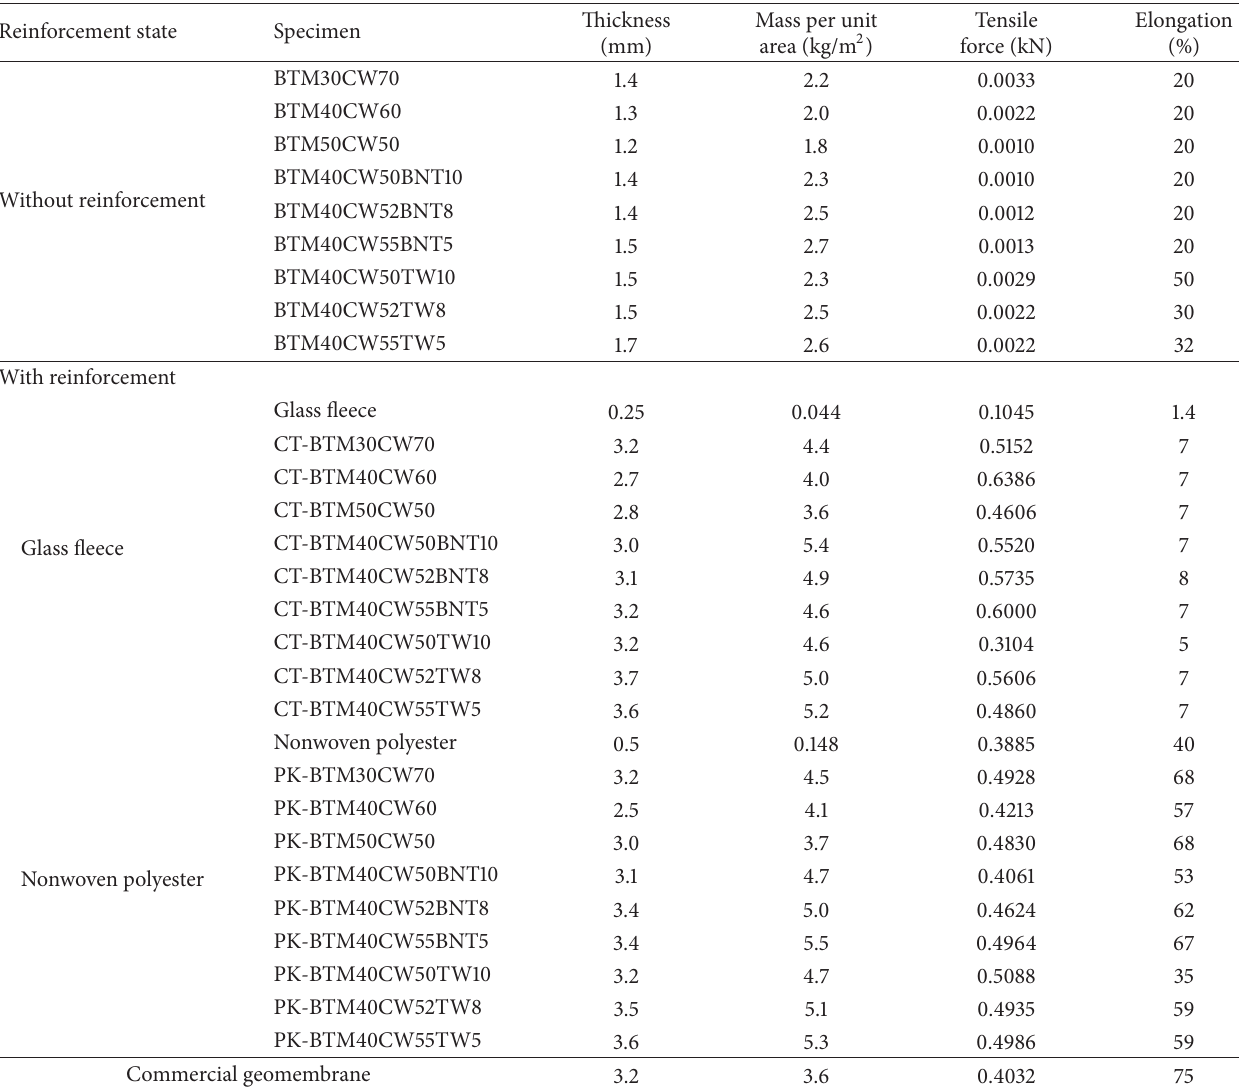
Table 3: Physical properties of all specimens and constituents.